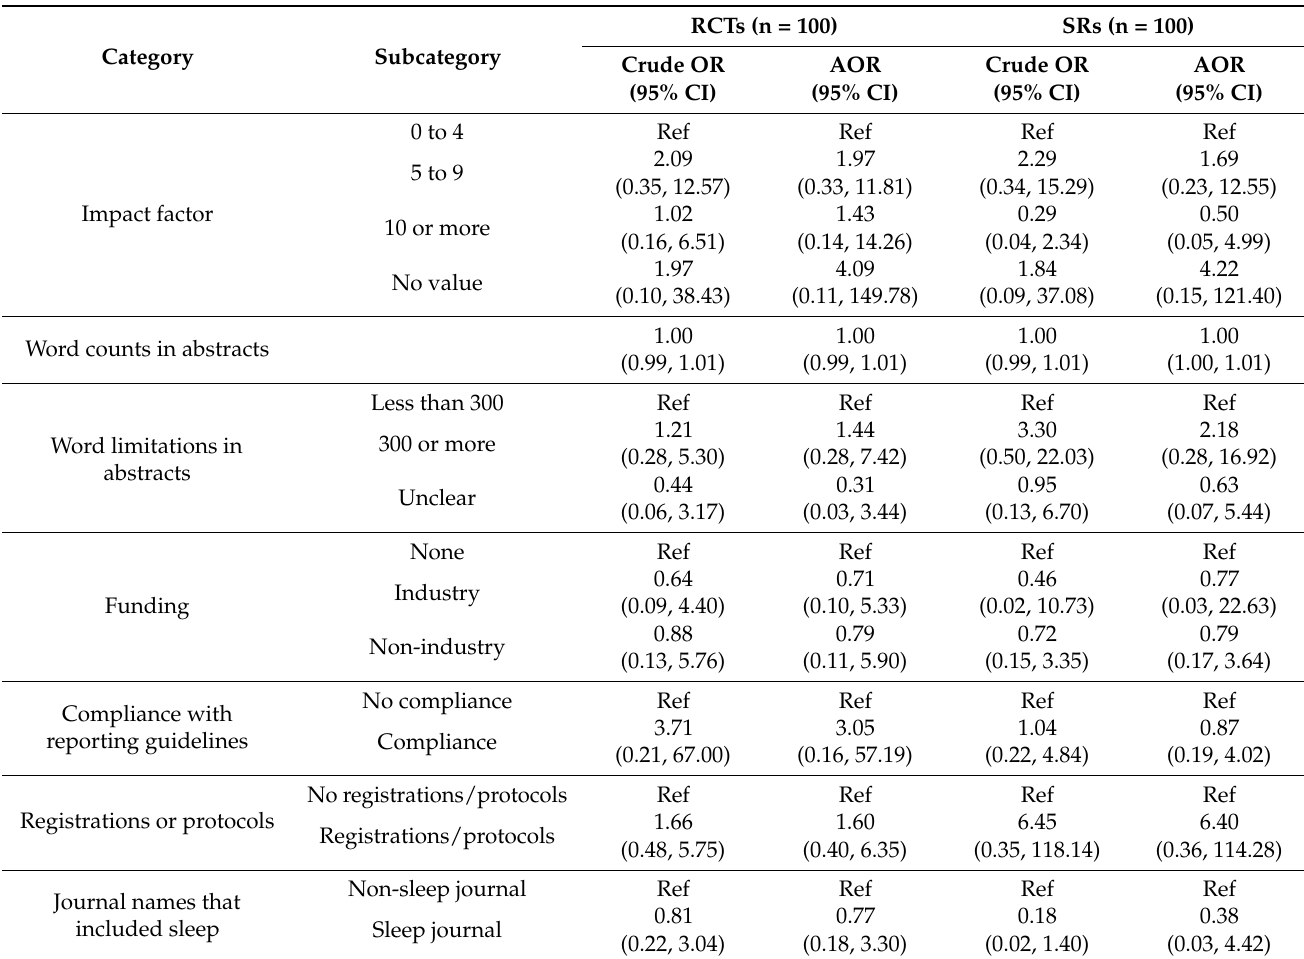
Table 3. Factors associated with RCT and SR abstracts in which the insomnia concept is